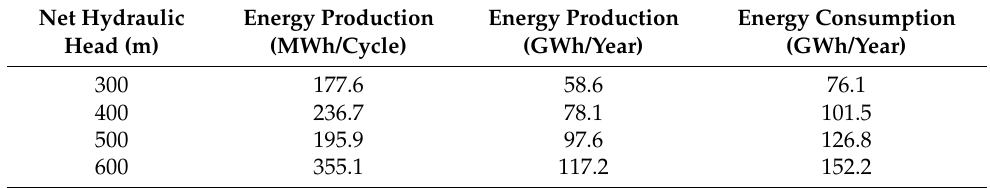
Table 1. Energy production and consumption as a function of the UPHS hydraulic head (lower reservoir capacity: 0.25 Mm 3